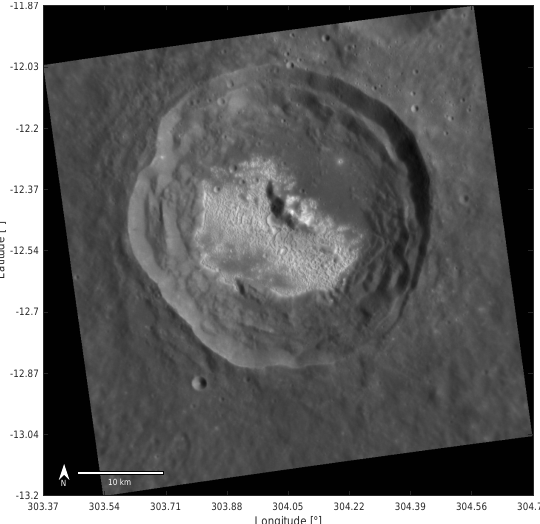
Figure 3. MDIS-NAC image EN0223616383M of Hopper crater. A large part of the floor and the central peak is covered by hollows, easily recognizable by their high